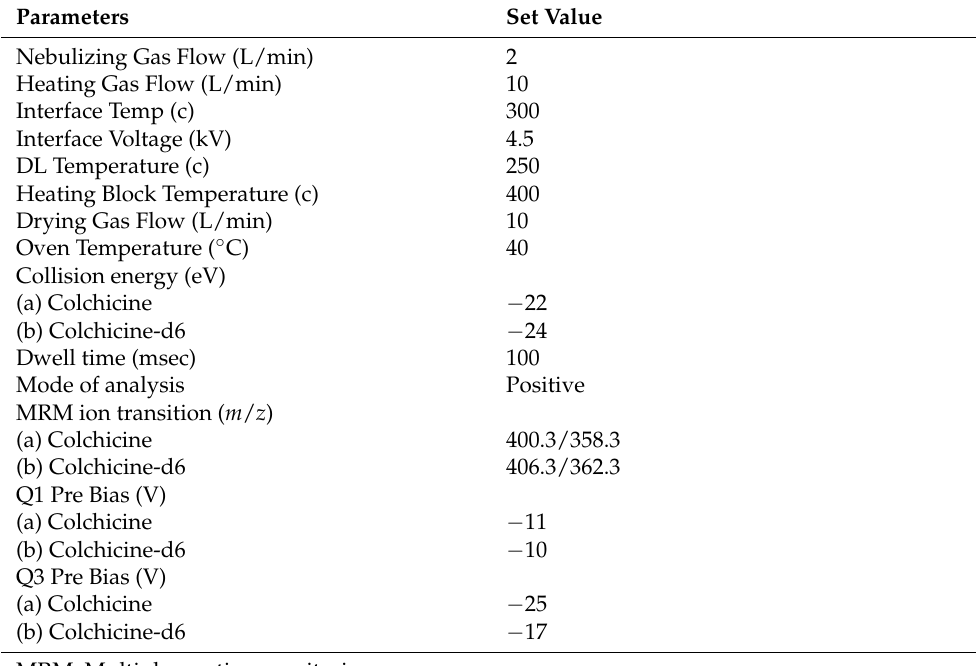
Table A1. MS/MS source dependent and compound dependent parameters for COL and